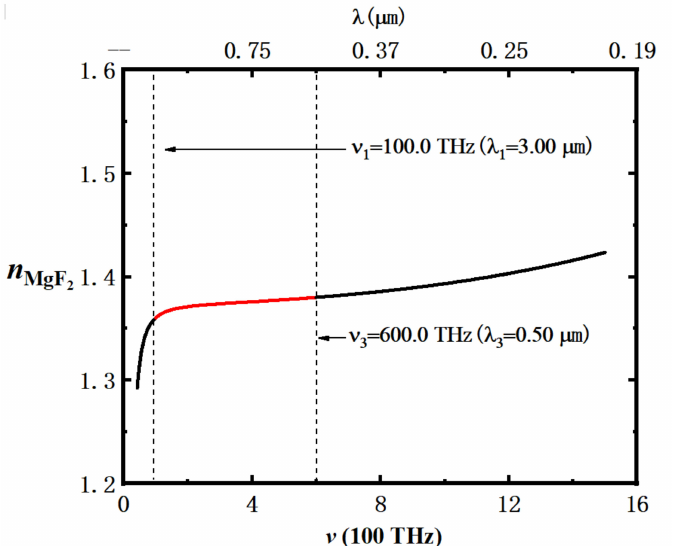
Figure 2. The dispersion curve of MgF 2 defined by Equation (4): the red curve indicates the frequency range studied in this paper, and the black thin dashed line is the scale line at the frequency endpoint and communication wavelength studied in this article, and its values are v 1 = 100.0 THz ( λ 2 = 3.0 µ m ) , v 3 = 600.0 THz ( λ 3 = 0.5 µ m ) ,